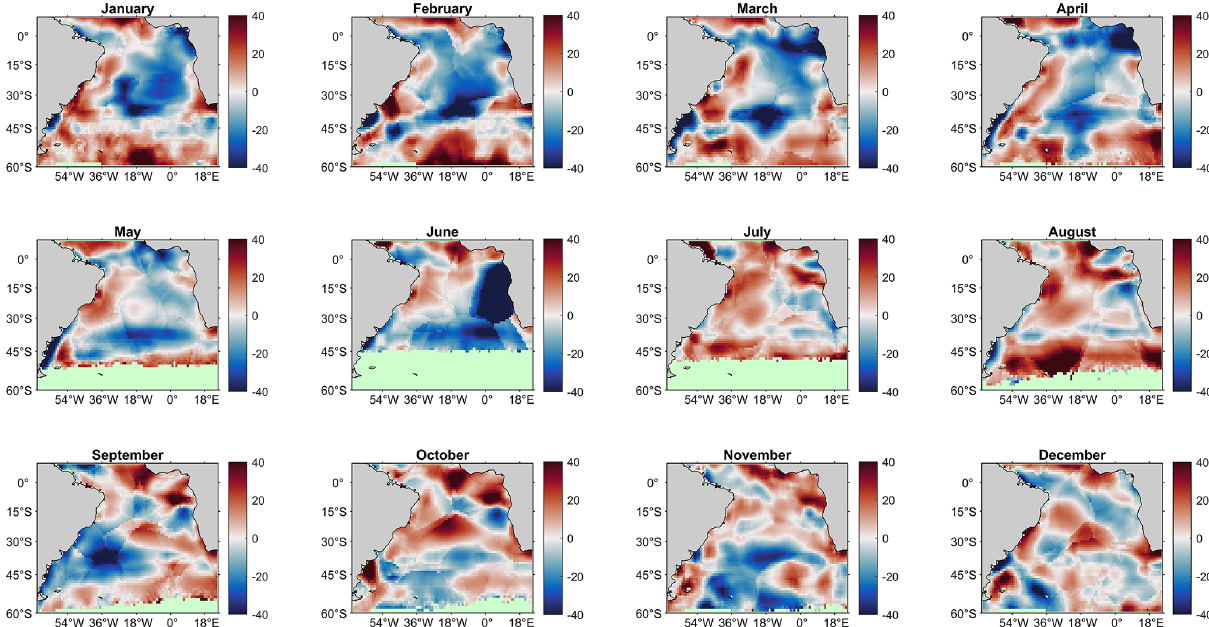
Figure B2. Monthly comparison between p CO 2 ( sw ) climatology estimated by the SA-FNN NCP and Woolf et al. (2019) climatology ref- erenced to 2010 (SA-FNN NCP p CO 2 – Woolf p CO 2 ). Red (Blue) shades indicate regions where SA-FNN is greater (less) than the Woolf